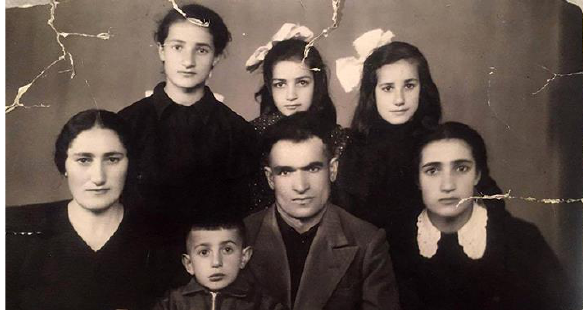
Figure 17. Master Petros and his family, 1950s. Photo from the Karapetyan family archive.